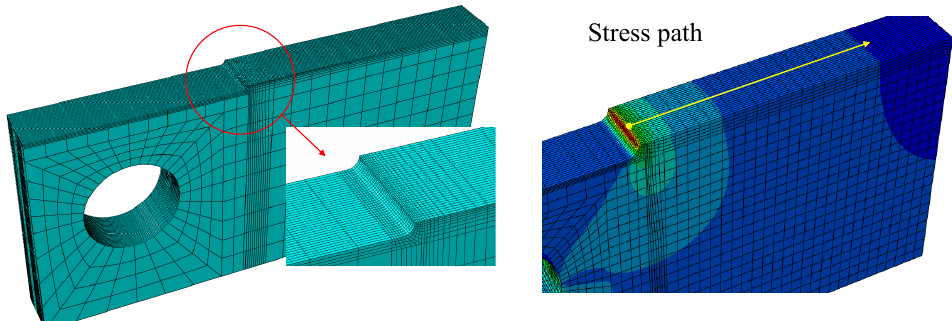
Figure 10. Finite element model for one-half of the CT symmetric specimen used in the numerical simulations ( left ) and the geometrical path selected ( right ).